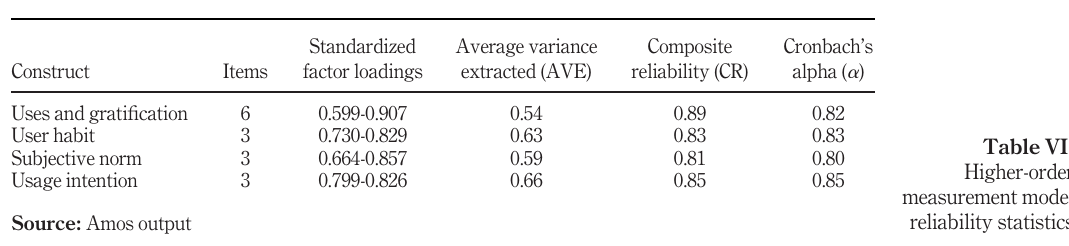
Table VI. Higher-order